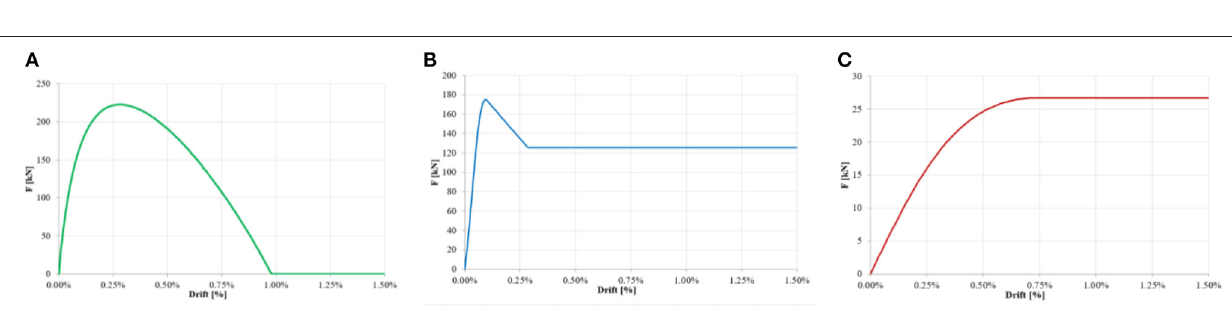
( Figure 21B ). The backbone curves of the infill contributions for the three infill typologies taken into account are reported in Figure 22